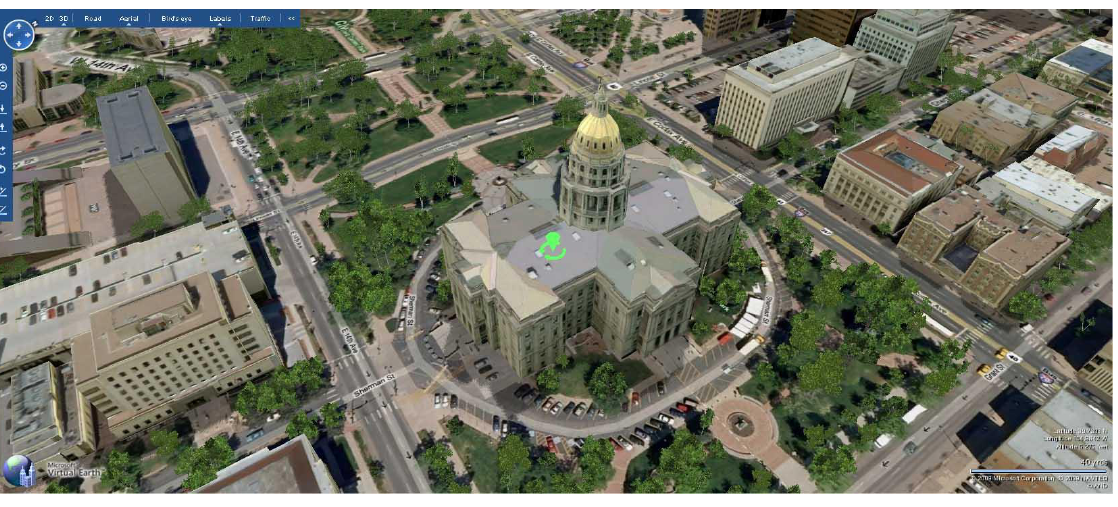
Figure 1. Typical 3D content in support of an Internet search, taken from www.bing.com/maps . The focus is on providing a pleasant ―user experience‖. The example is the Colorado State Capitol . The geometry is from vertical aerial photography, the photo-texture from separate aerial oblique imagery. The vegetation has been classified and computer generated trees have been placed at the locations classified as